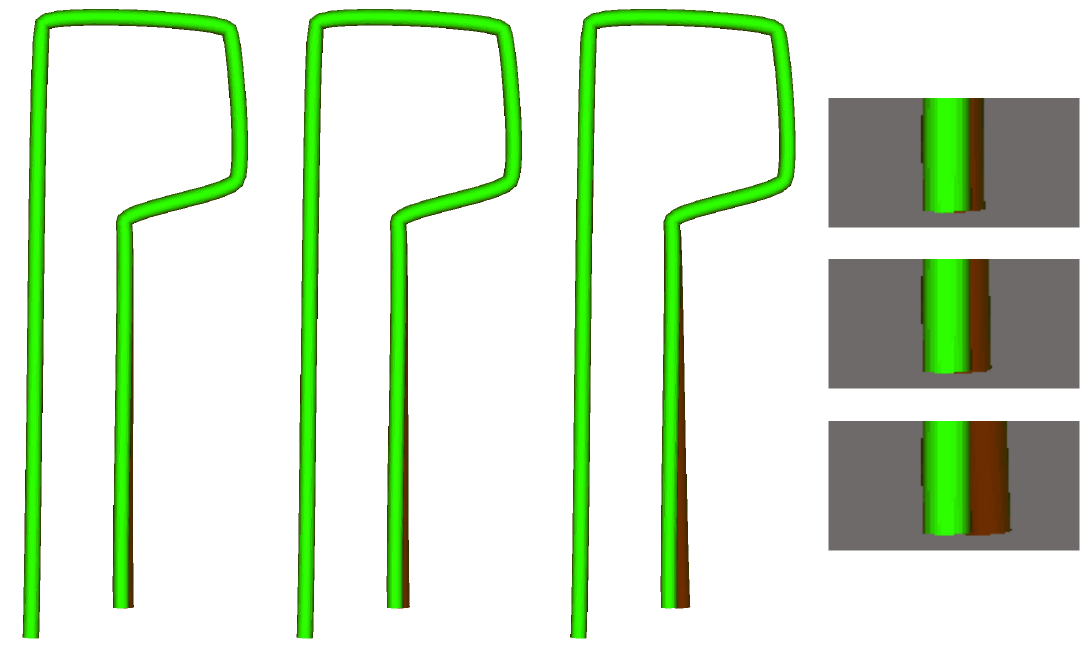
Figure 5. Synthetic wire figures used for experimentation. The bright green surface is the perfect (average) model, while the dark red areas illustrate a test object with increasingly larger deformations.